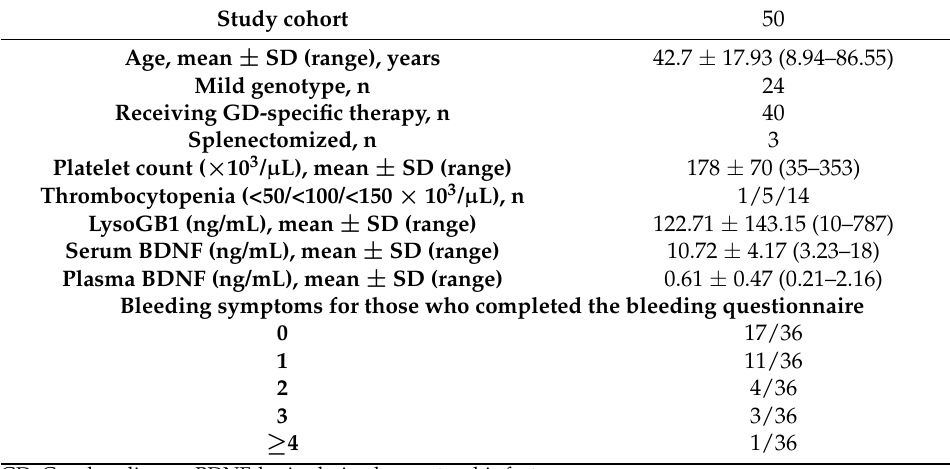
Table 1. Clinical and laboratory characteristics of study